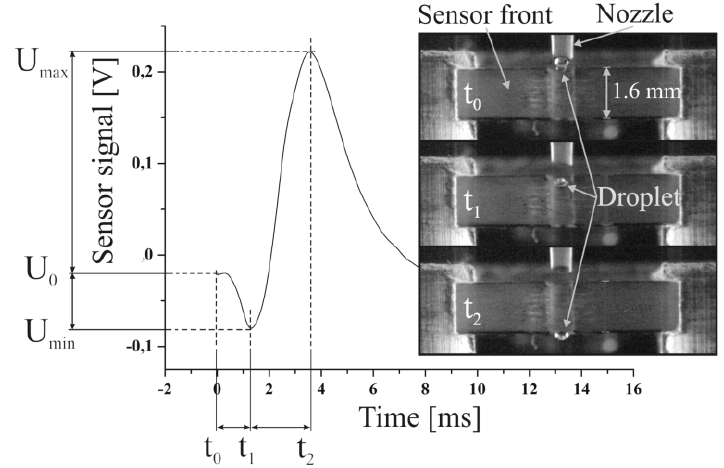
Figure 1. Previously achieved experimental signal characteristics correlated to droplet positions while a droplet is passing the